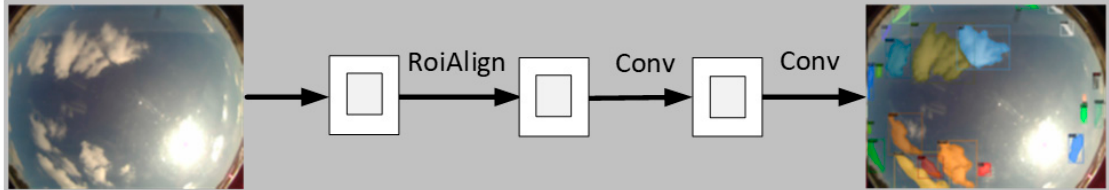
Figure 3. Instance segmentation using Mask R-CNN, based upon the R-CNN detection network (adapted from [29]).